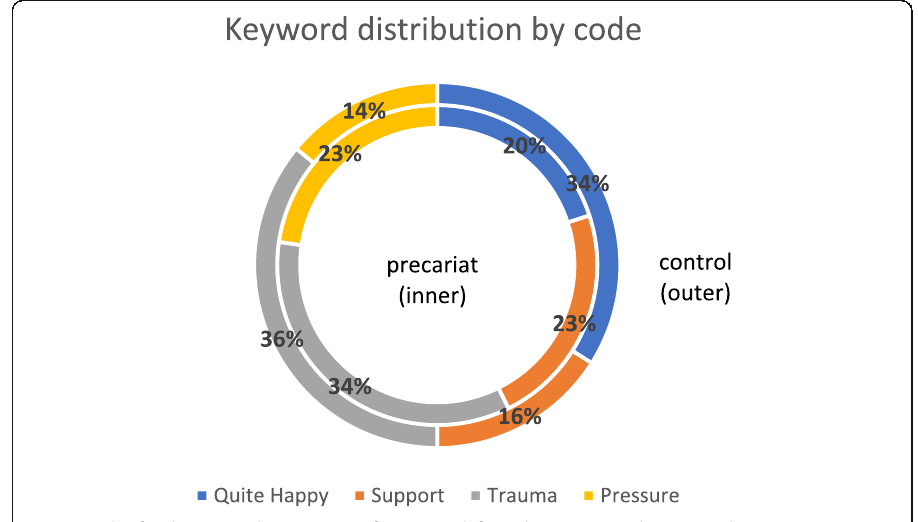
Fig. 1 Codes for themes in the accounts of precariat (left) and NCDS control group